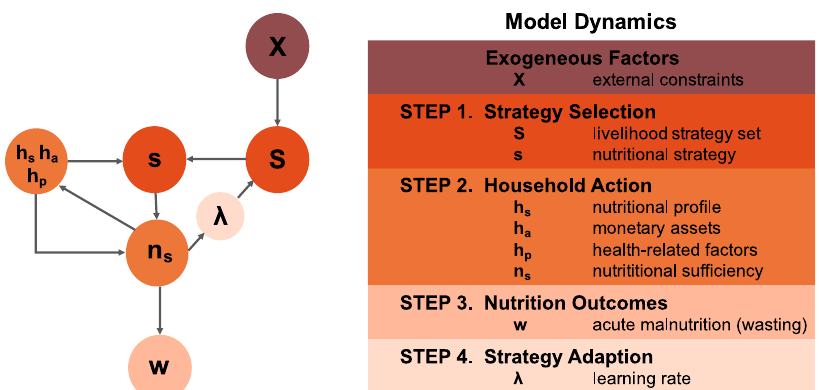
Fig. 2 Model speci fi cation. The left panel depicts the conceptual fl ow of the computational model; the right panel provides an overview of model dynamics and